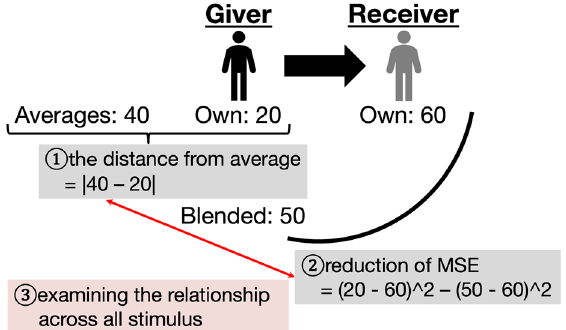
Figure 5. Illustration of the analysis in the ‘Individual differences’ Section. (1) We first calculated the ‘distance from the average’, which indicates the taste typicality of a Giver. Specifically, we computed the absolute distance between the Giver’s Own opinion and the averages of all Own opinions. (2) Subsequently, we analysed the ‘reduction of the MSE (Mean Squared Error)’ to use our method for all stimuli. This was calculated by subtracting the case when the Giver’s opinion was a Blended opinion from when it was an Own opinion. (3) Finally, we examined the relationship between the distance from the average and the reduction in MSE. In particular, we calculated the correlation coefficient between them. We assigned all participants, except the Giver, to Receivers and performed this analysis. Additionally, we assigned all participants to Givers and conducted the same procedure.